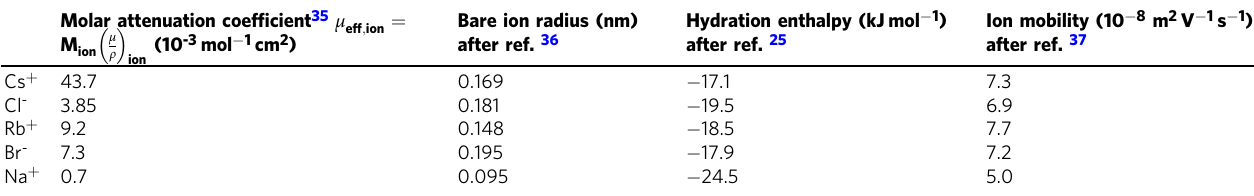
Table 1 Effective (molar) attenuation coef fi cients, bare (crystal) ion radii, hydration enthalpies and ion mobilities for Cs + , Cl − Rb + , Br − , and Na + ions in aqueous solution ¼ (cid:1) (cid:3) Bare ion radius (nm) Molar attenuation coef fi cient 35 μ eff ; ion (10 -3 mol − 1 cm 2 ) after ref. M ion μ ρ ion